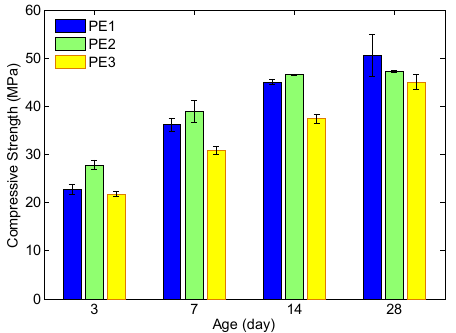
Figure 6. Measured compressive strength results of three types of ECC specimens with age.